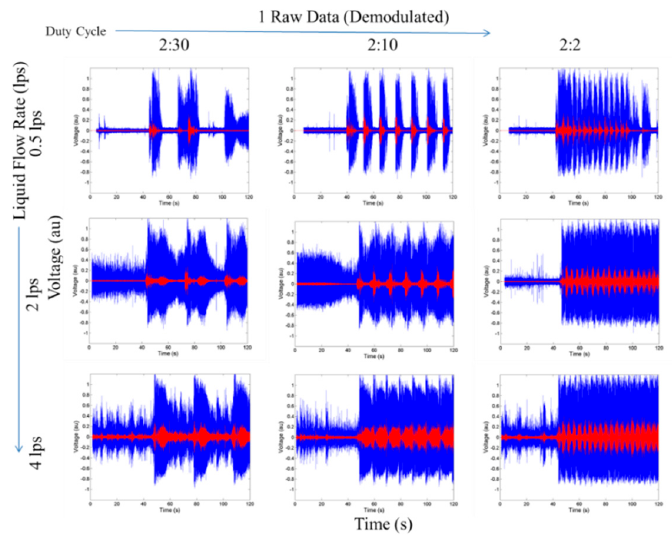
Figure 8. The continuous-wave Doppler ultrasound (CWDU) reflection voltage (normalised) time- domain signals against time for various slug trains. Raw signals are in blue, and the corresponding bandpass-filtered signals (0.95–1.05 kHz) are shown in red. The Y-axis limits of each plot in this figure are 0 volts to 1 volt and the X-axis limits are 0 s to 120 s.